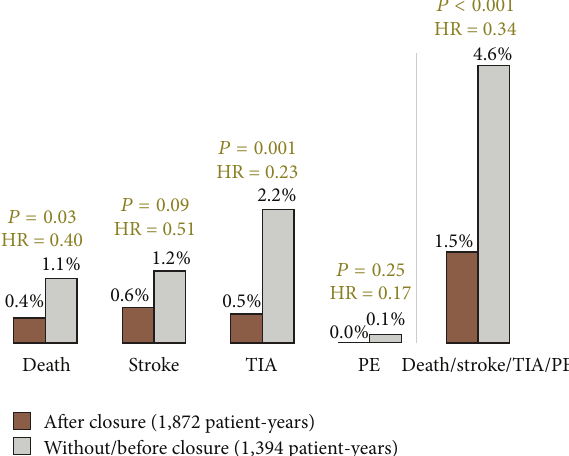
Figure 5: Annual event rates during a 10-year follow-up in 308 consecutive patients randomly assigned to PFO closure or medical treatment. PE = peripheral embolism and TI = transient ischemic